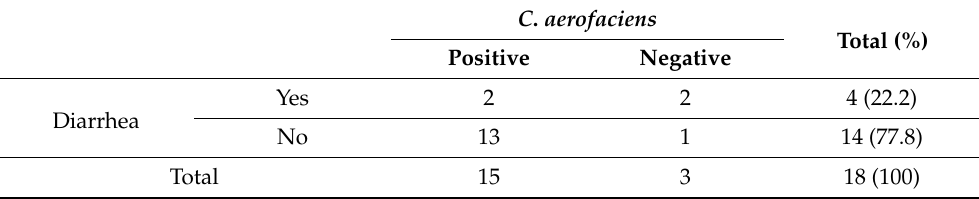
Table 4. Relationship between the presence of E . coli and physical activity in adolescents.